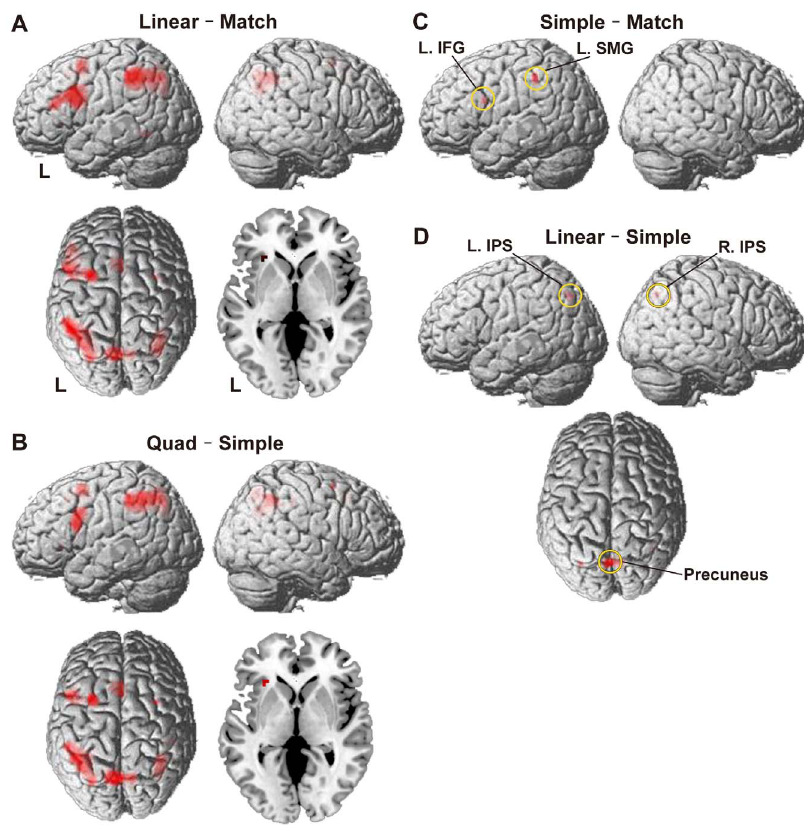
Figure 3. Significantly activated regions in the arithmetic task. Cortical activation maps are shown for the contrasts of Linear – Match (A), Quad – Simple, masked with Linear – Match (B), Simple – Match (C), and Linear – Simple (D). Activation is projected onto the left (L) and right lateral surfaces of a standard brain (family-wise error corrected P , 0.05), as well as onto the dorsal surface where there was significant activation. A transverse plane at z =1 shows activation in the left anterior short insular gyrus. See Tables 3 for the stereotactic